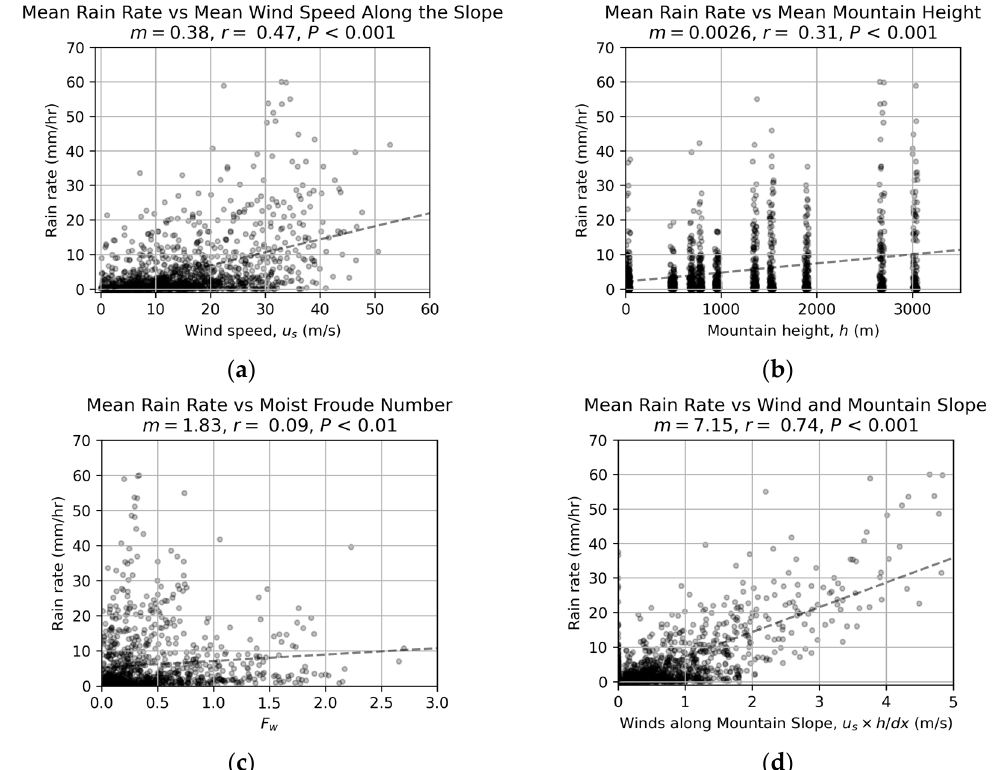
Figure 12. Mean rain rate over the slopes of the CMR as compared with ( a ) the upslope wind speed, u s , ( b ) mountain height, h , ( c ) F w , and ( d ) the product of wind speed, u s , and mountain slope. Each data point represents 3-hourly periods at different times around TC landfall: from 24 h before landfall, the time of landfall, and up to 24 h after landfall. The comparisons that include wind speeds ( a , d ) do not include winds coming from the west. The dashed lines show the least-squares regression slope for each relationship. The Pearson correlation coefficient ( r ) and p -value ( P ) are included above each plot.